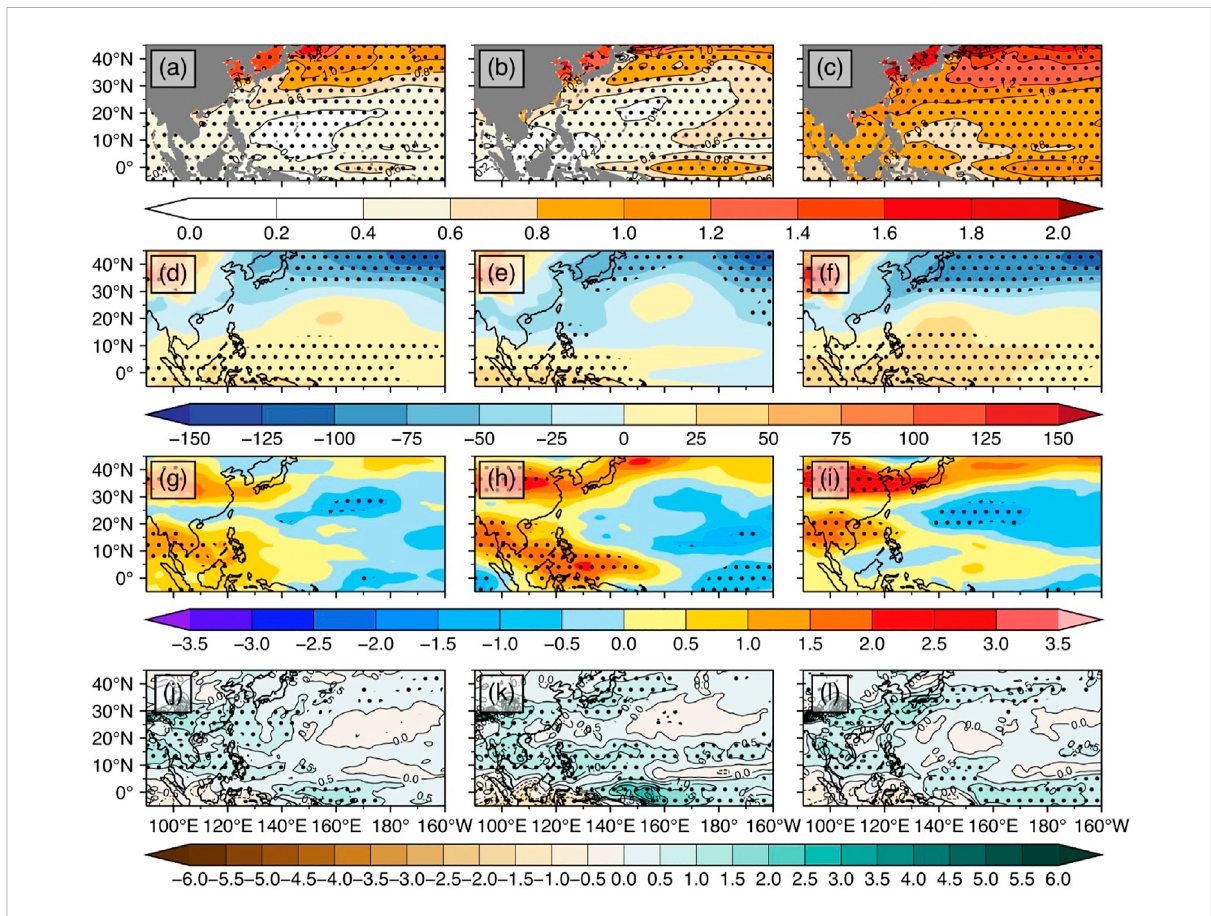
FIGURE 2 Changes of June-to-October monthly mean sea surface temperature ( ° C) in the end of 21st century, de fi ned as the 2011 – 2020 mean subtracted from the 2091 – 2100 mean, under the (A) 1.5degNE, (B) 1.5degOS, and (C) 2.0degNE scenarios. (D – F) , (G – I) , (J – L) show similar calculations but for sea level pressure (hPa), zonal wind shear (m/s), and total precipitation rate (mm/day), respectively. The area covered by the points passed the 95% signi fi cance